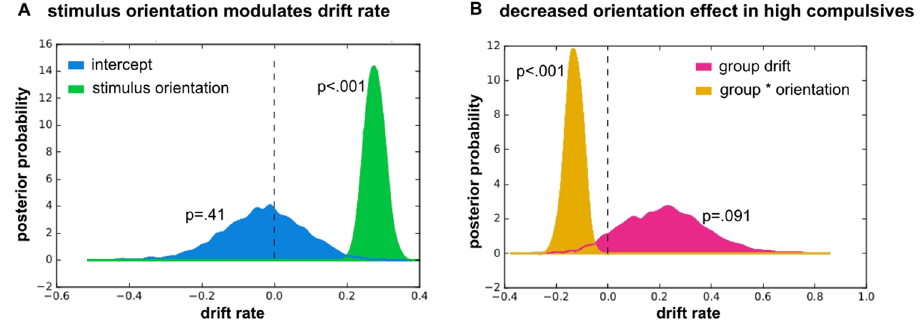
Figure 3. Stimulus processing is altered in high compulsive participants. ( A ) Signal strength (stimulus motion orientation) significantly increases drift rate across both groups (green). This effect entirely accounts for drift rate, as the orientation-independent drift rate (‘intercept’, blue) is not significantly different from 0. ( B ) The groups differ in in how much the stimulus motion orientation affects the drift rate: high compulsive participants benefit significantly less from an increasing stimulus orientation (orange). There is no additional effect of group on the drift rate